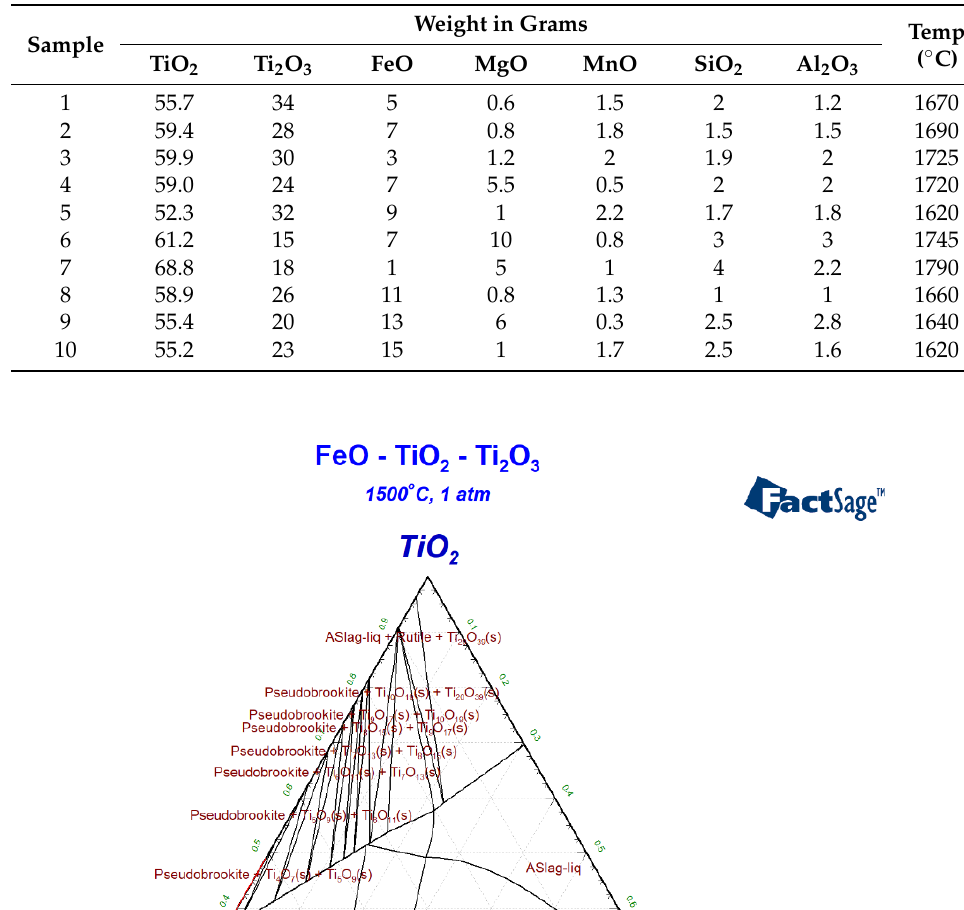
Table 1. Sample weight of components (in grams) and the liquidus temperature for each test.